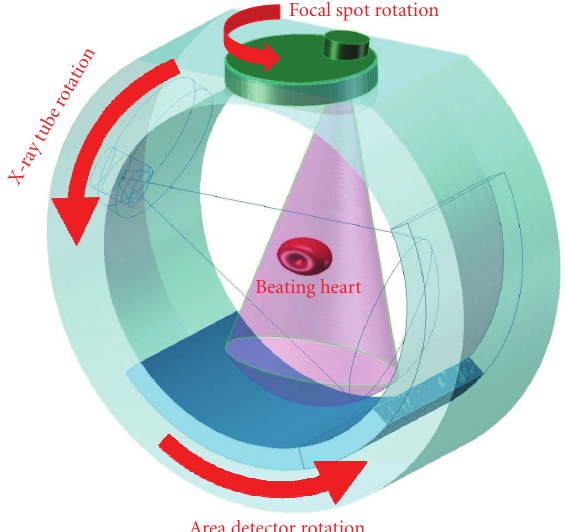
Figure 2: Compositing-circling scanning mode. In such a CT sys- tem, the scanning trajectory is a composition of two circular mo- tions: while an X-ray focal spot is rotated on a plane facing a short object to be reconstructed, the X-ray source is also rotated around the object on the gantry plane. Once a projection dataset is ac- quired, exact or approximate reconstruction can be done in a num- ber of ways (Copyright by Wang G, Yu HY, US Provisional Patent Application, 2007).